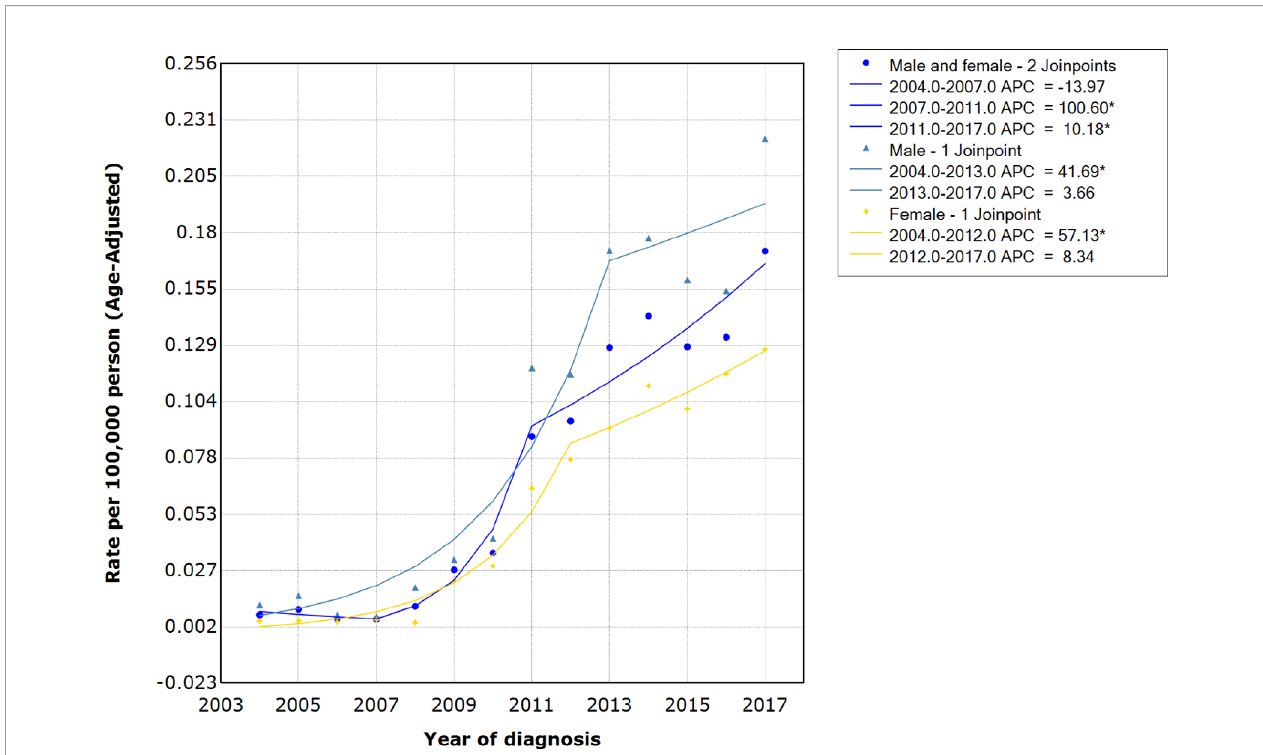
FIGURE 2 | Incidence rates and APCs of patients with HIV-associated CTCL. APCs, annual percentage changes; HIV-associated CTCL, human immunode fi ciency virus associated cutaneous T-Cell